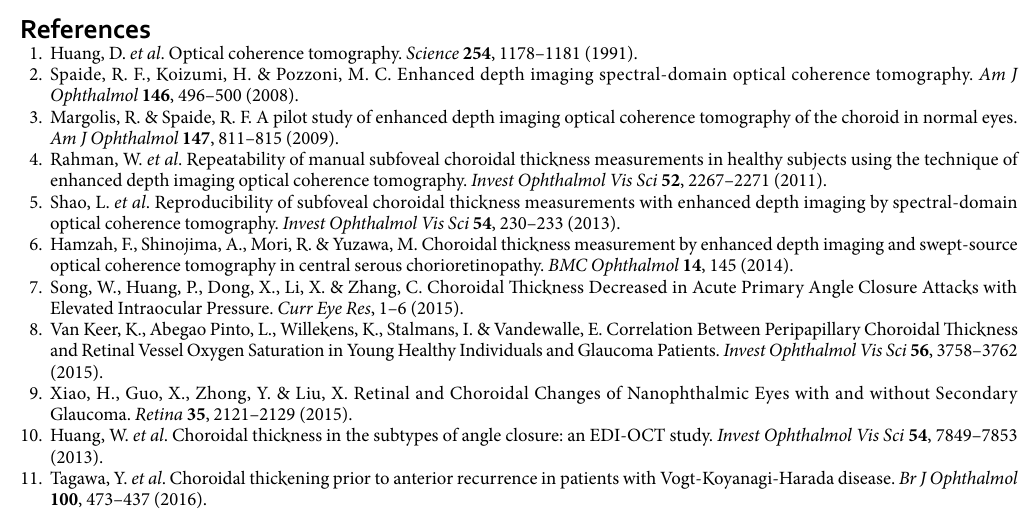
Measurement of linear artifact and subfoveal choroidal thickness. All participants were examined by two retinal specialists independently of each other. Two high-quality horizontal and vertical 9 mm EDI line scans across the fovea were obtained from each eye using the spectral-domain OCT device (wavelength: 870 nm; scan pattern: enhanced depth imaging; Spectralis; Heidelberg Engineering, Heidelberg, Germany). Eye motion artifacts were eliminated by a proprietary eye tracking device, and 100 frames of EDI OCT images were captured and automatically averaged to reduce speckle noise. The SFCT was measured using the manual calipers of the proprietary device, was taken at the fovea, and was defined as the distance between the outer part of the hyper-reflective line corresponding to the base of the RPE and the hypo-reflective line or margin corresponding to the sclerochoroidal interface 4 . The SFCT values of the horizontal and the vertical scans were averaged for analysis. The depth of subfoveal linear artifact was measured from the base of the RPE to the upper end of the three hyper-reflective bands similar to the ellipsoid zone, the interdigitation zone and the RPE/Bruch’s complex. As demonstrated in Fig. 4, the thickness of the linear artifact was defined as the distance between the upper and the lower end of the three hyper-reflective bands. Each OCT figure was reviewed by at least two of the readers. The SFCT and the depth and the thickness of the linear arti- fact were measured by at least two experienced readers independently and the values were averaged to get the reported results if the difference in the measurements of the readers was within 15% of the mean of the values. In a few cases, there was disagreement in measurement, and the determination was referred to Dr. Liu, the senior author.